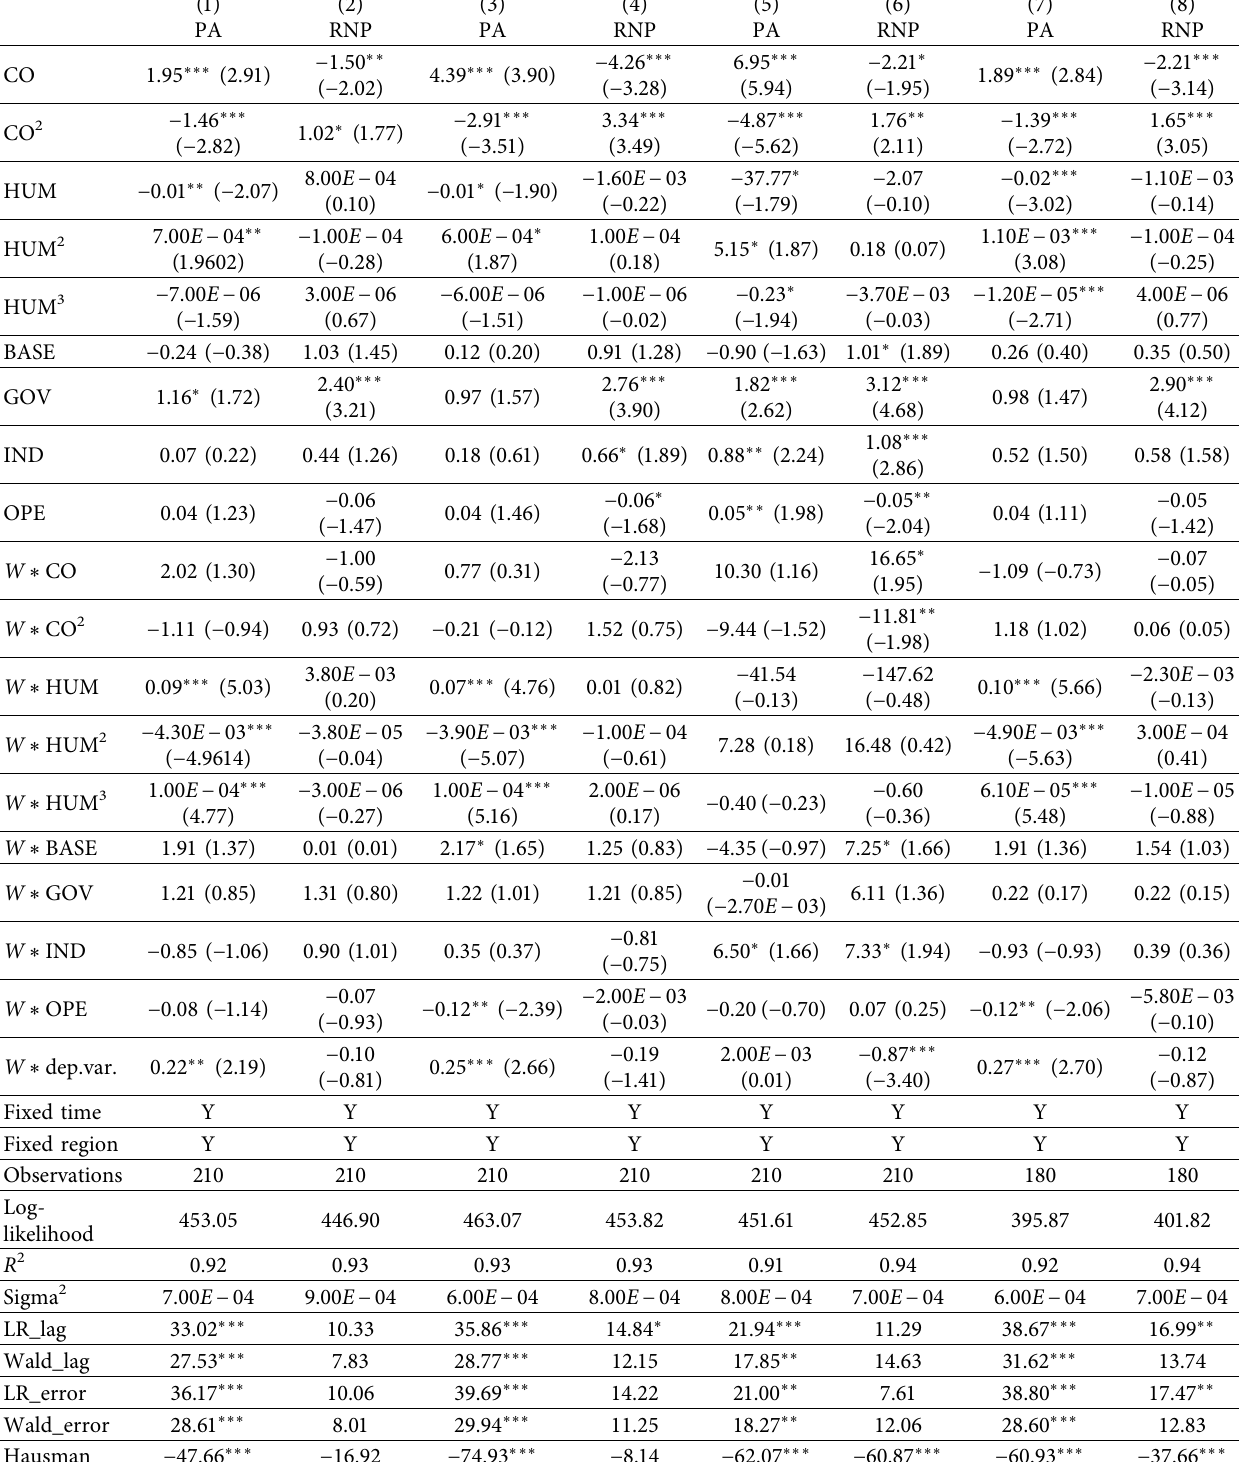
Table 9: Results of robustness